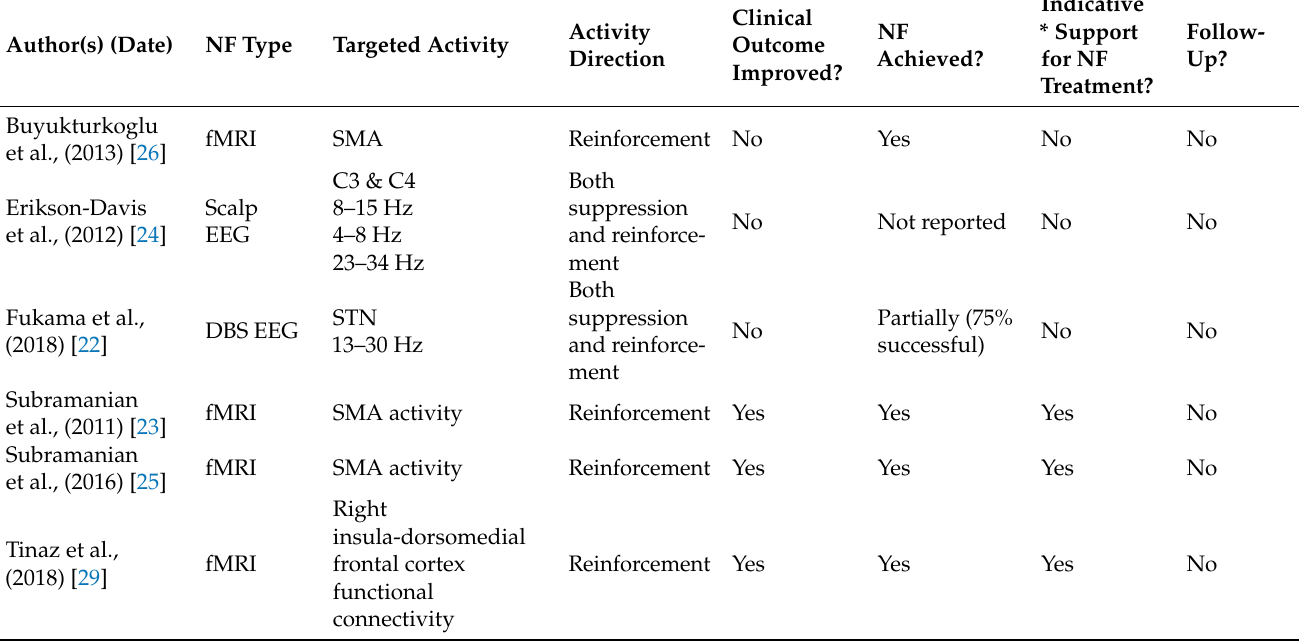
Table 5. Treatment summary